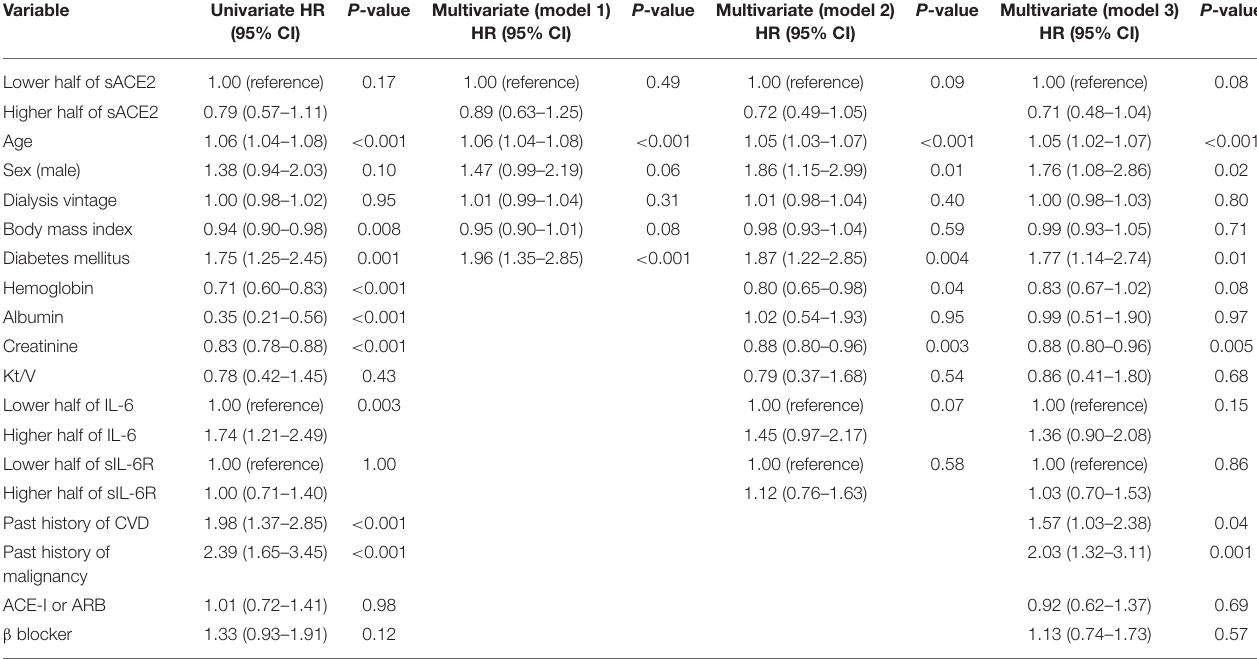
TABLE 3 | Univariate and multivariate Cox proportional hazard models of all-cause death. Variable